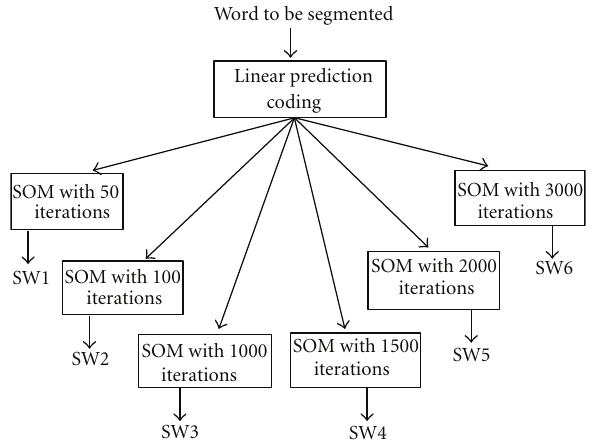
Figure 2: SOM segmentation block.